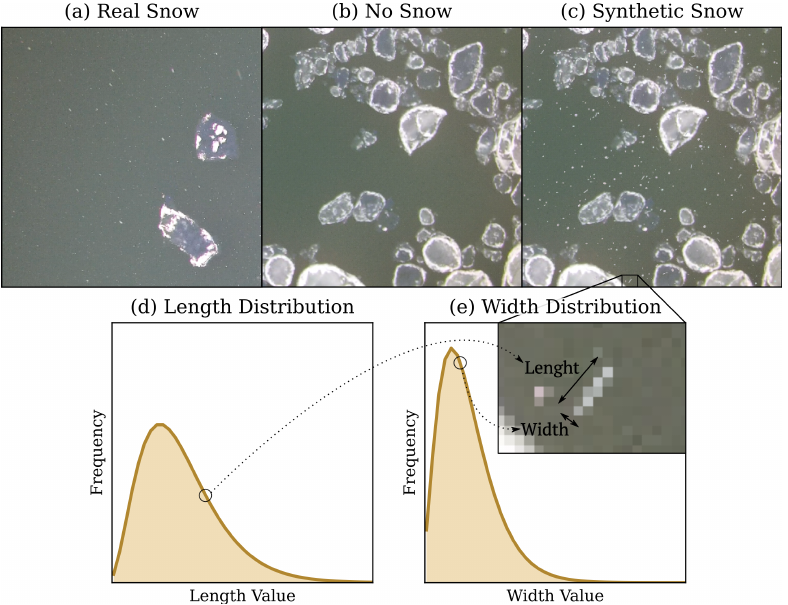
Figure 3. Examples from the Alberta River Ice Segmentation Dataset [43] taken while it is snowing ( a ), while it is not snowing ( b ), and with synthetic snow added to an image which originally had no snow ( c ). An example of a synthetic streak-like snowflake is shown with its length and width sampled from gamma distributions for length ( d ) and width ( e ). The distribution for length ( d ) can be seen to have a larger mean and standard deviation than the distribution for width, forcing some streak-like snow as shown in the zoomed in square. Note that snow can be seen better when zoomed